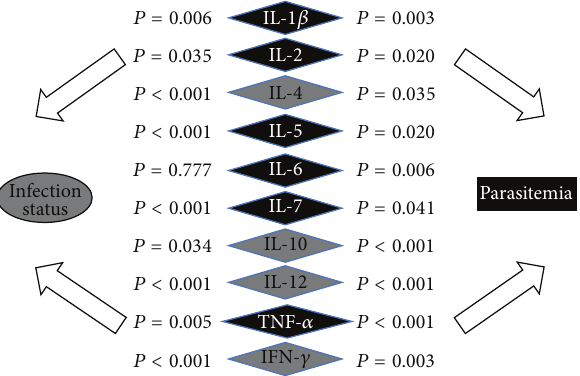
Figure 5: Multiple mediation model. Inflammatory mediators were correlated with the independent variable (infection status, 𝑃 values to left of mediators) and parasitemia ( 𝑃 values to the right of mediators) individually, and those with significant correlations with the dependent variable (parasitemia) were used to populate the multiple mediation model. All nonparametric variables were log transformed. “infection status” was dummy coded as follows: Pf [+] monoinfected = 0; bacteremia coinfected = 1. The multiple mediation model was populated with ten inflammatory mediators that showed significant correlation with parasitemia, with age used as a covariate, and processed using 10,000 bootstrap samples. Post hoc pair-wise contrasts for the four significant mediators (black type; IL-4, IL-10, IL-12, and IFN- 𝛾 ) were evaluated by examining the bootstrapped confidence intervals, with those intervals not including zero being